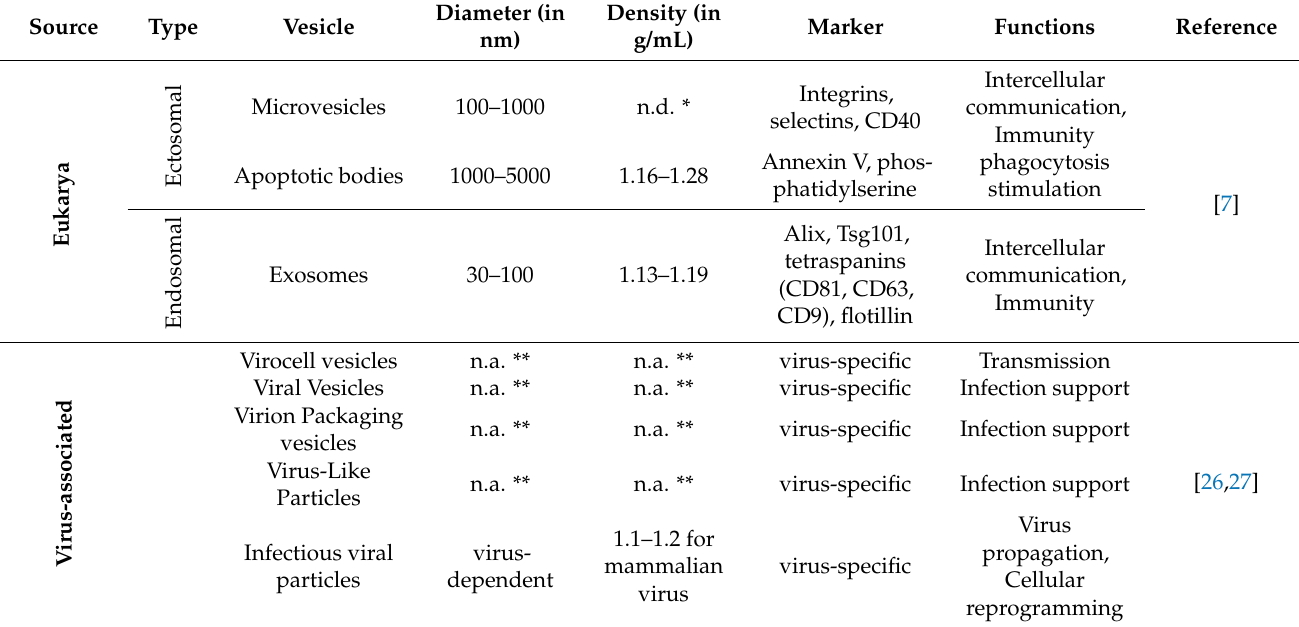
Figure 2. Extracellular vesicles and viral particles. The top lists enveloped viruses associated with EVs, the bottom non-enveloped viruses. On the left, mechanisms detrimental for viruses (antiviral) are listed, on the right, beneficial mechanisms (proviral). Viral families giving rise to the viral vector systems discussed here in bold. Functions most useful for viral vector systems in bold. TLR toll-like receptor, v.a. vector associated. Modified from Nolte-′t Hoen et al. [26]. Table 1. Overview of Eukaryotic Extracellular